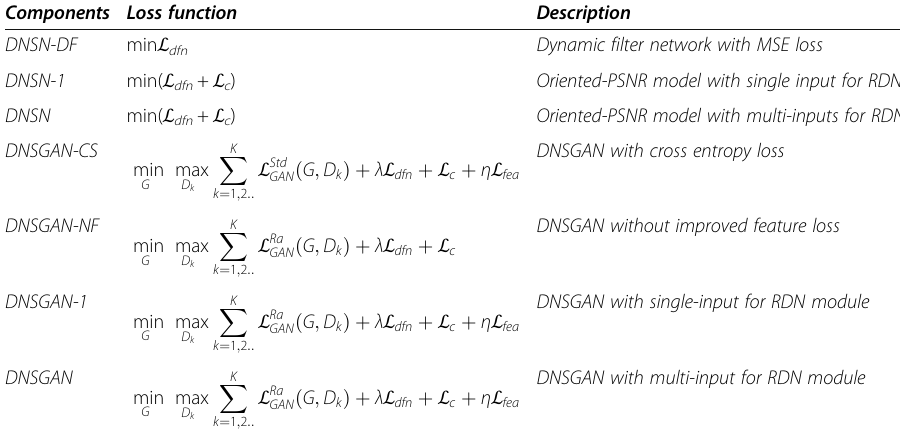
Table 1 Summary of components and loss functions Components Loss